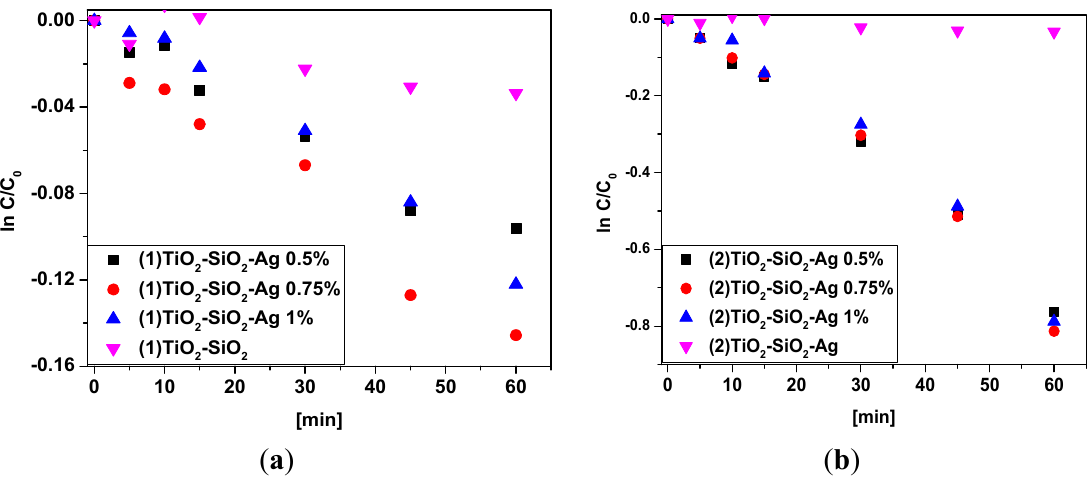
Figure 1. Degradation curves of salicylic acid using the in situ preparation method of (1) TiO 2 -SiO 2 -Ag ( a ) and mixing the precursors of TiO 2 -SiO 2 -Ag-based nanocomposites ( b